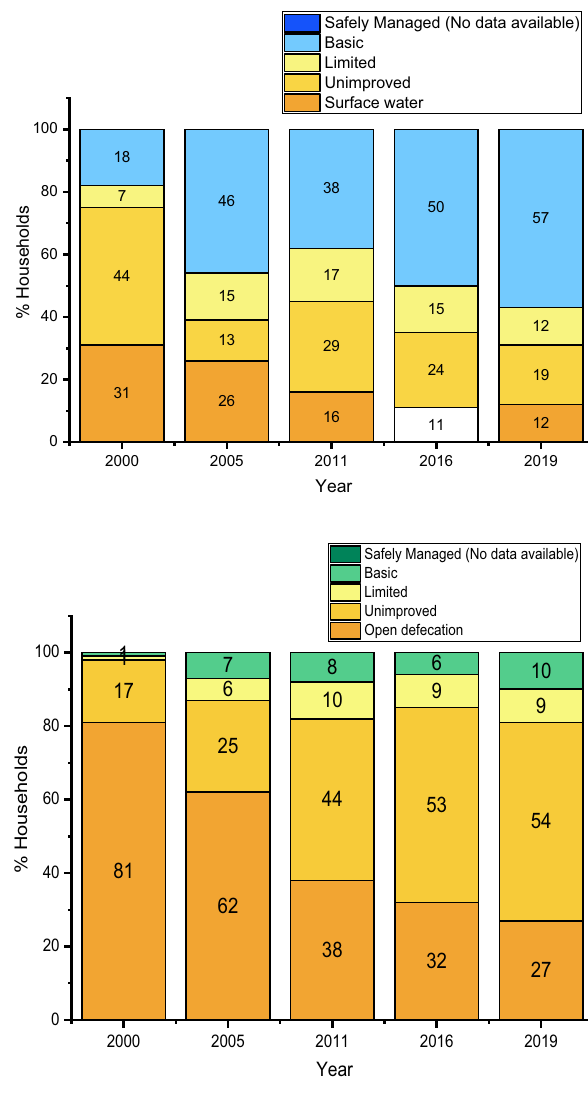
Fig. 3 Trends of JMP ladders for drinking water services in different survey years